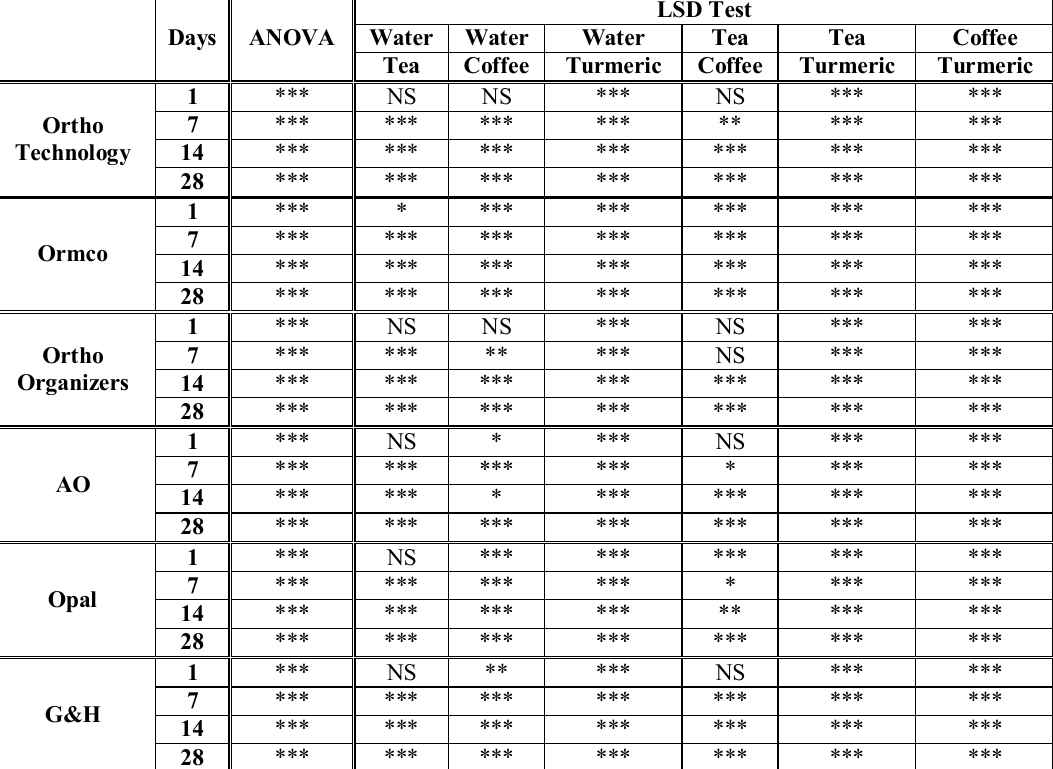
Table 3: Statistical difference between the color changes of the clear elastomeric chains immersed in different dietary